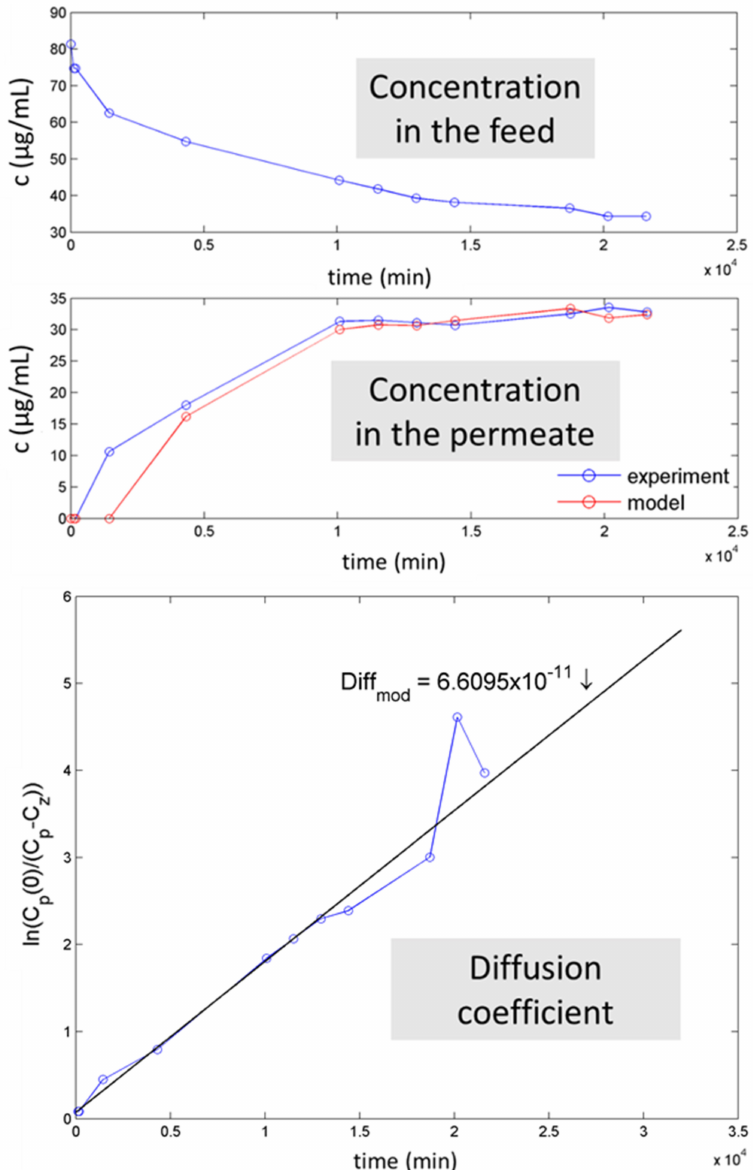
Figure 14. Concentration in the feed and permeate in time and an example of the calculation of the diffusion